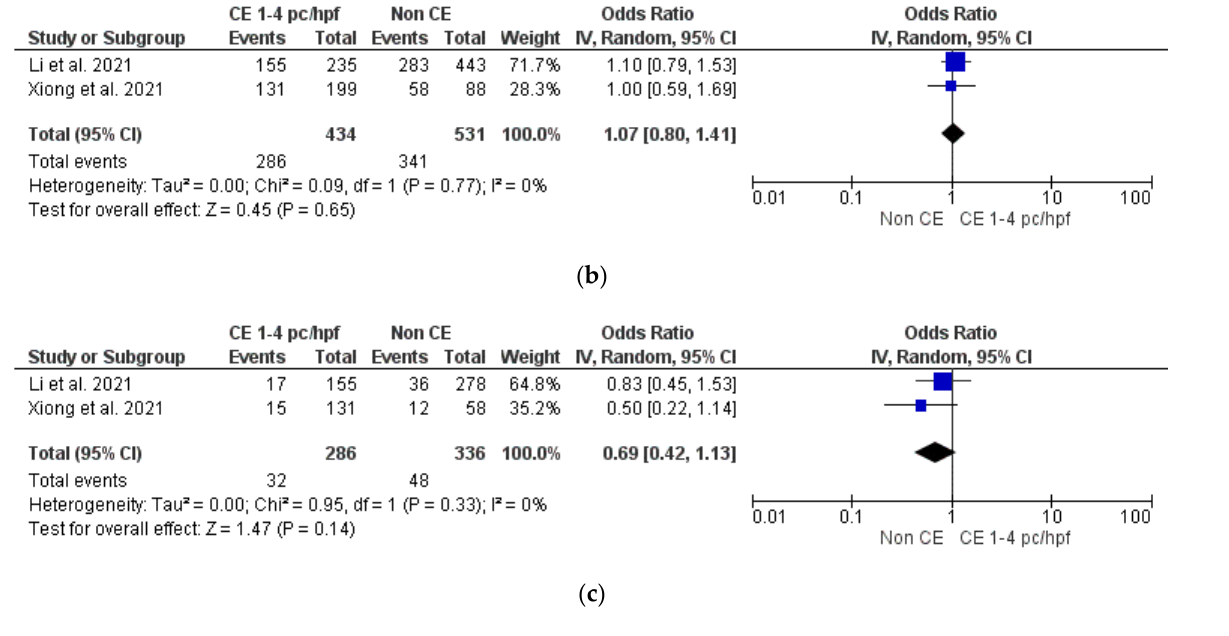
Figure 7. Pooled data analysis comparing mild CE versus non-CE: ( a ) ongoing pregnancy rate/live birth rate; ( b ) clinical pregnancy rate; ( c ) miscarriage rate [9,10].